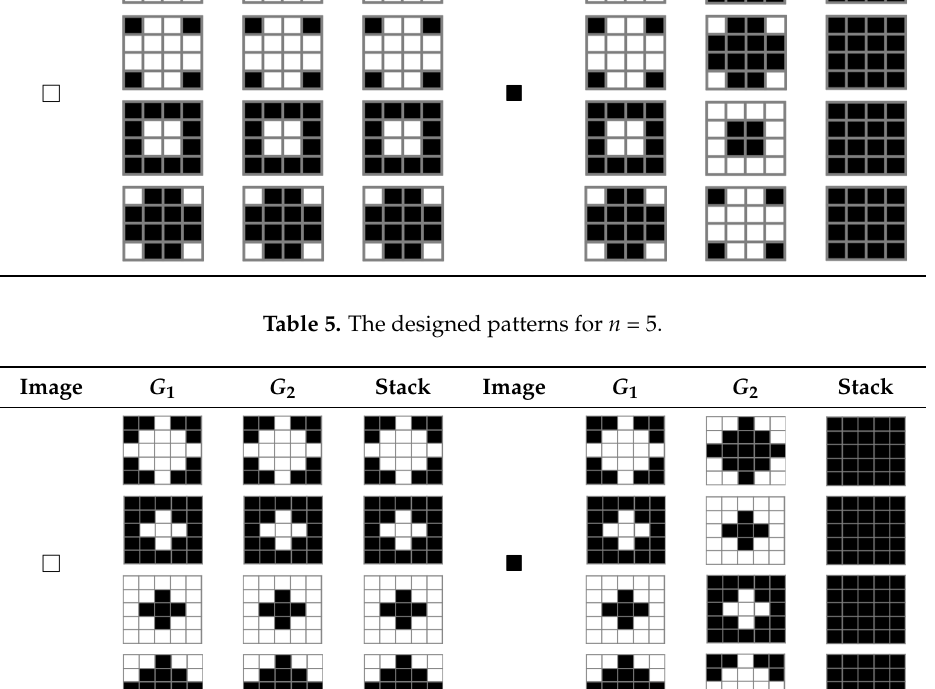
Table 4. The designed patterns for n = 4.